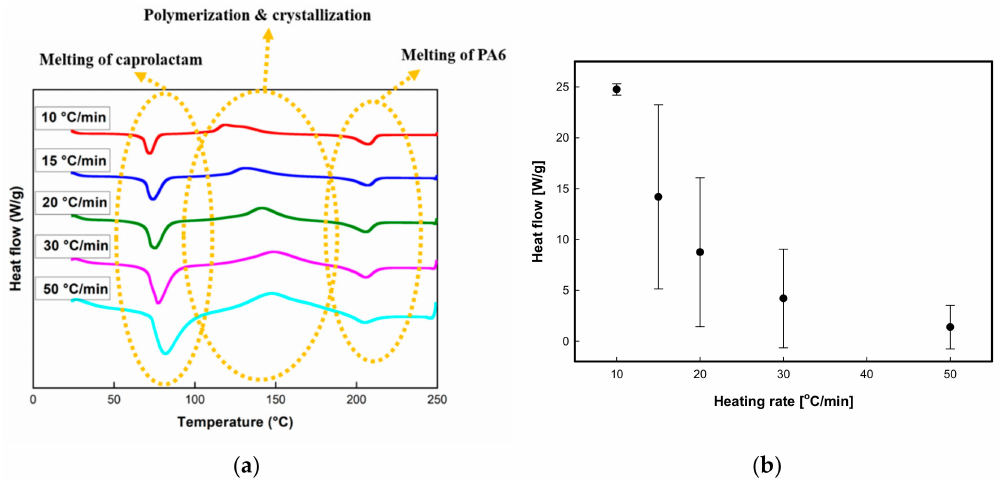
Figure 8. DSC thermograms of caprolactam ( a ): DSC thermograms of caprolactam at five di ff erent heating rates, ( b ): normalizing heat flow at di ff erent heating rates).